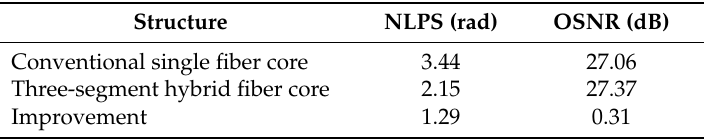
Table 4. Summary of performance improvement result.